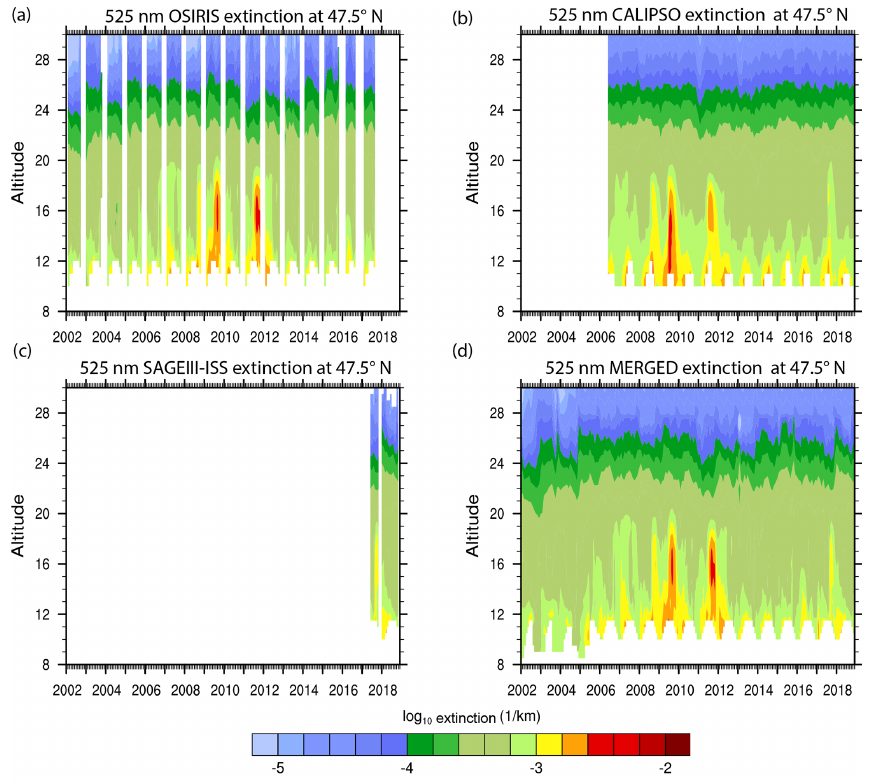
Figure 13. Altitude versus monthly time series of the 525nm extinction coefficient at 47.5 ◦ N latitude. (a) Bias-corrected OSIRIS extinction coefficient, (b) bias-corrected CALIOP extinction coefficient, (c) cloud-cleared SAGE III/ISS extinction coefficient and (d) final merged 525nm GloSSAC v2.0 extinction